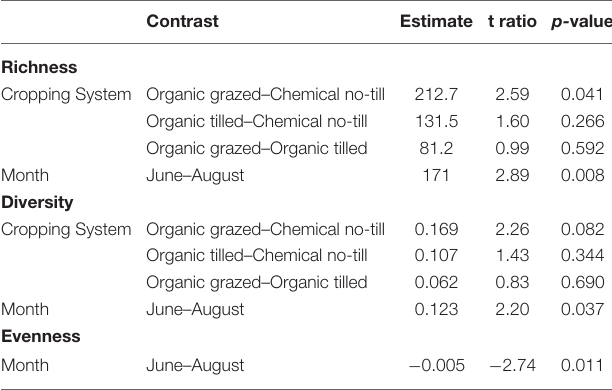
TABLE 2 | Pairwise comparisons from Tukey’s post-hoc analysis of alpha diversity models.